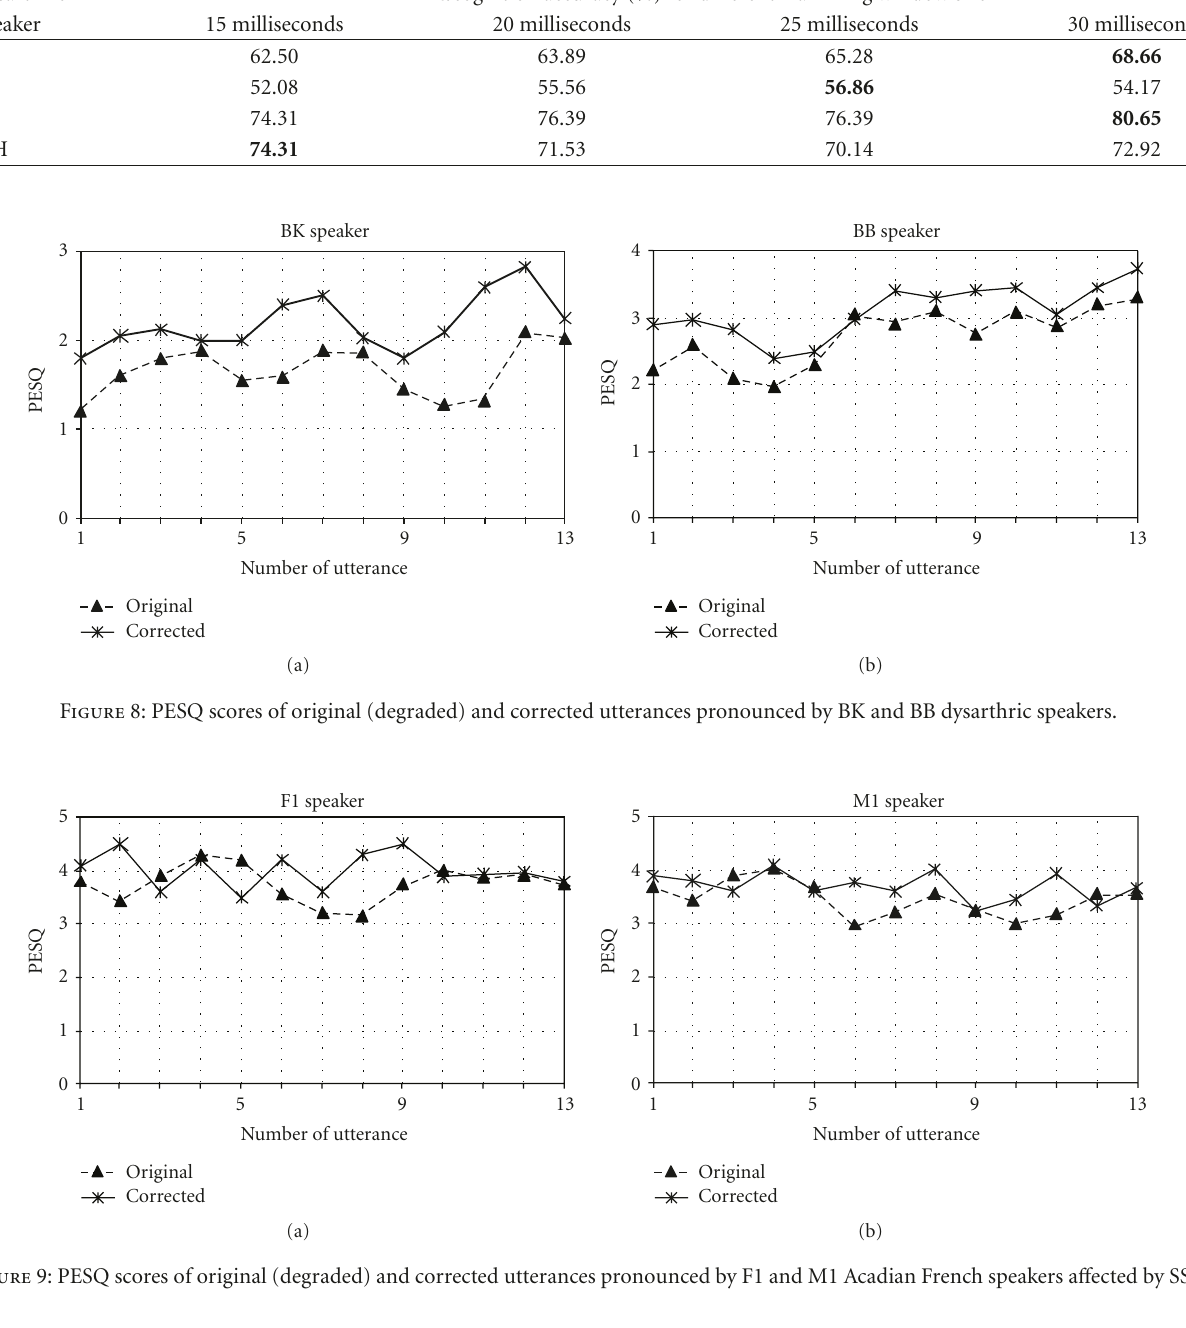
Table 2: Speaker dependent ASR system performance with and without language model and using the Acadian French pathologic corpus.